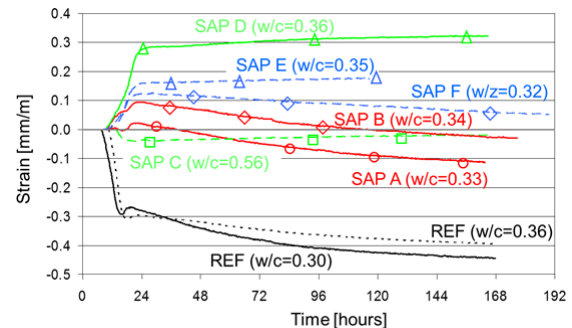
Figure 3. Results of dilatometer tests on the reference mortar and mortar modified with SAP (nomenclature according to Fig. 2); dosage of SAP 0.3% bwoc and w/c adjusted to meet the slump flow value of 19 cm±1 cm. The differences in autogenous strain result from different molecular structure of SAP under investigation and subsequently from their various sorption